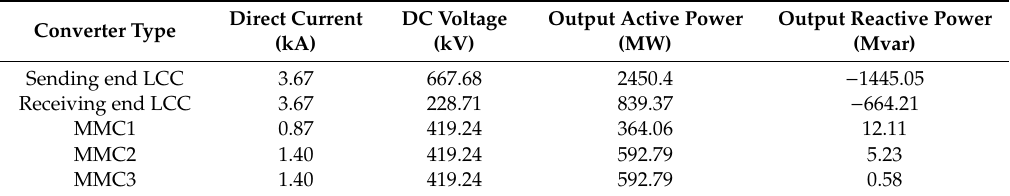
Table 4. Optimization Results.